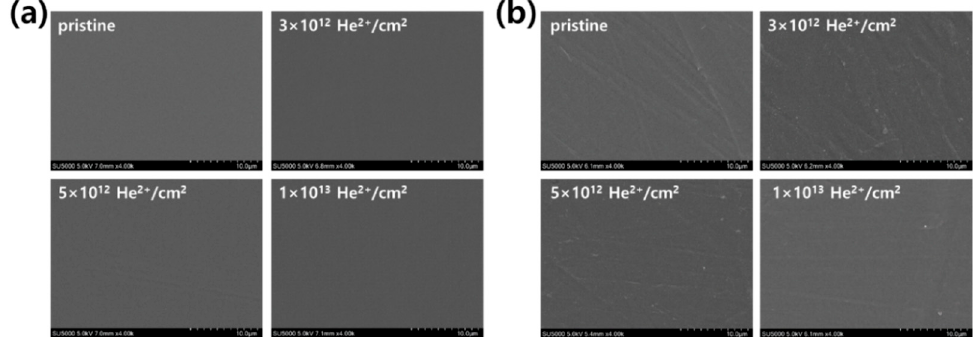
Figure 2. Top surface FE-SEM images of ( a ) PS and ( b ) HDPE irradiated at various fluences.